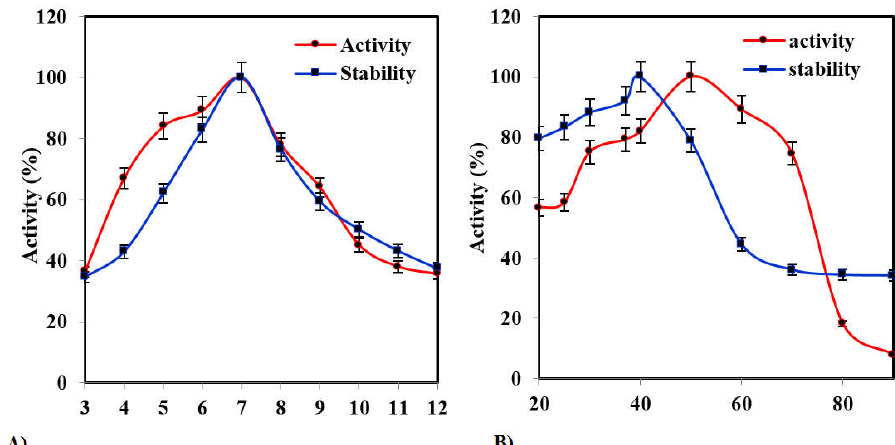
Fig. 4. The effect of various pH values and temperatures on the activity and stability of UMF29 alpha-amylase: Effect of various pH values (A); Effect of various temperatures (B); The effect of pH and temperature on enzyme activity was assayed at various pH values (3.0-12.0) and temperatures (30-90 °C) , respectively, using 1% soluble starch under standard conditions. The stability profile of the enzyme was determined by measuring residual activity after any treatment at 37 °C . Table 1: The effect of different metal salts and additives on UMF29 alpha-amylase activity Metal ions and chemical additives Activity Metal ions and chemical additives Activity Fe 2+ (5 mM) 147 K + (5 mM) 102 205 Mg 2+ (5 mM) 82 T.X.100 (5 mM)